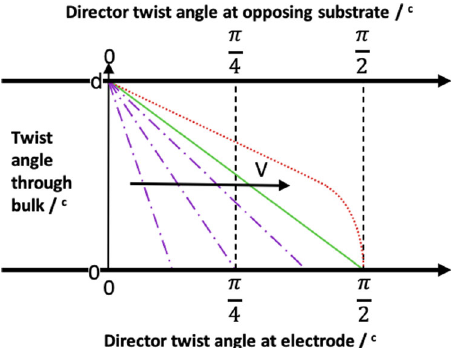
Fig. 2 Director twist with applied voltage. A schematic diagram showing how the total twist of the c -director is expected to vary through the cell ( z - direction) as a function of applied voltage. The interdigitated electrodes are located on the bottom axis of the diagram. The purple dotted and dashed lines show a twist less than 90°, or π radians. The green solid line shows an 2 optimum 90° twist through the device. The red dotted line shows an over- twist of the c -director, which results in a reduced